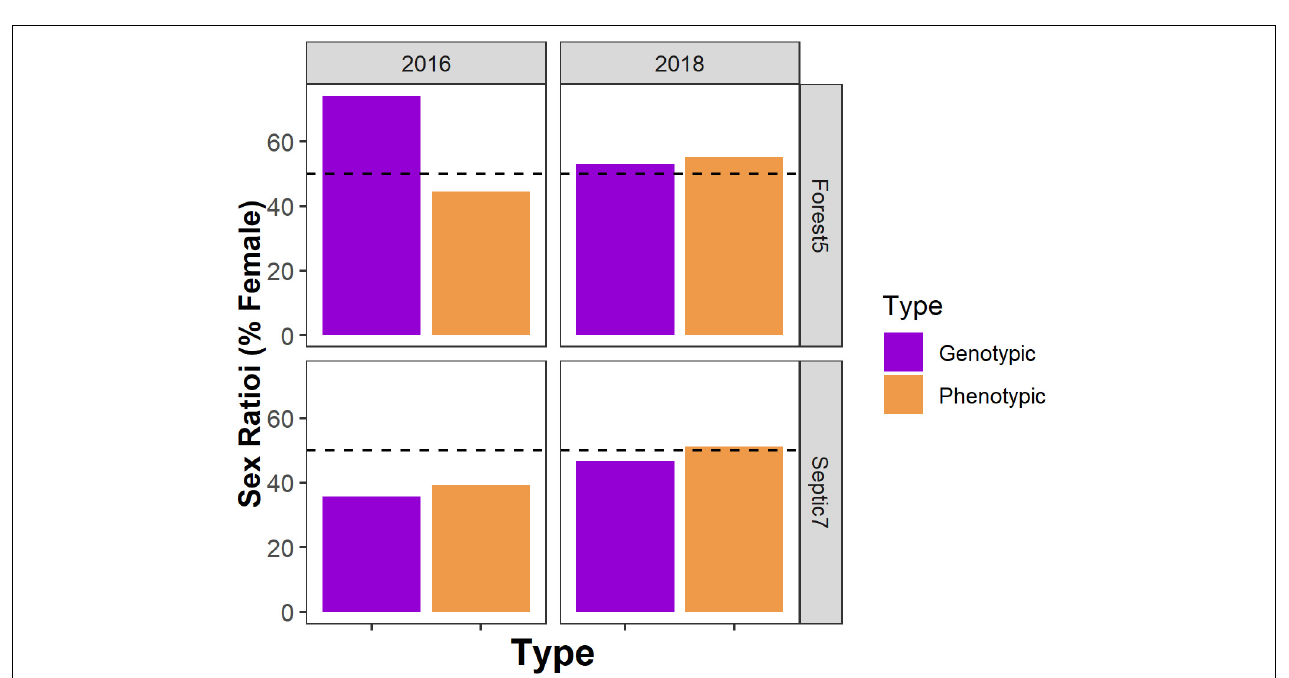
FIGURE 6 | Genotypic and phenotypic sex ratios vary not only among populations but also among years within a population. Horizontal dashed lines indicate a hypothetical 50:50 sex ratio. Here are genotypic and phenotypic sex ratio data from two focal ponds – Forest5 and Septic7 – in the years 2016 and 2018.